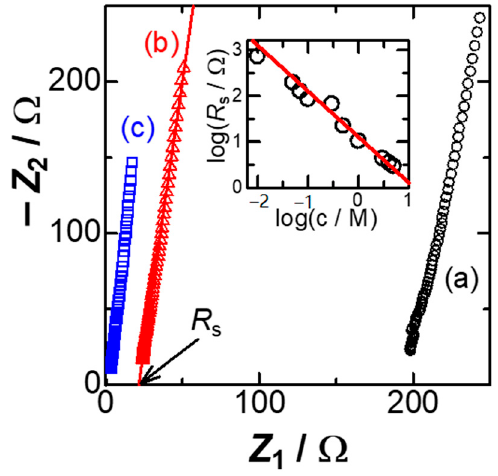
Figure 1. Nyquist plots at the Pt electrode in ( a ) 0.05, ( b ) 0.5 and ( c ) 5.0 M KCl aqueous solutions in the frequency domain from 300 to 5000 Hz at E dc = 0.0 V vs. Ag|AgCl. The inset is the